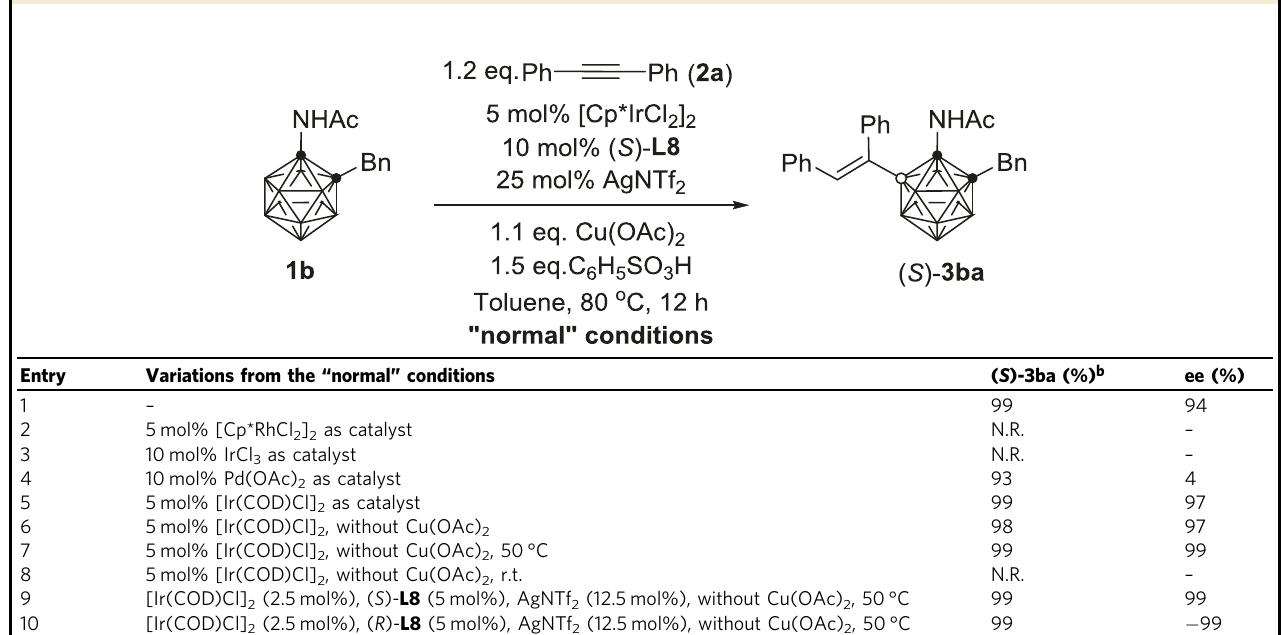
Table 2 Optimization of Ir-catalyzed asymmetric B – H alkenylation a